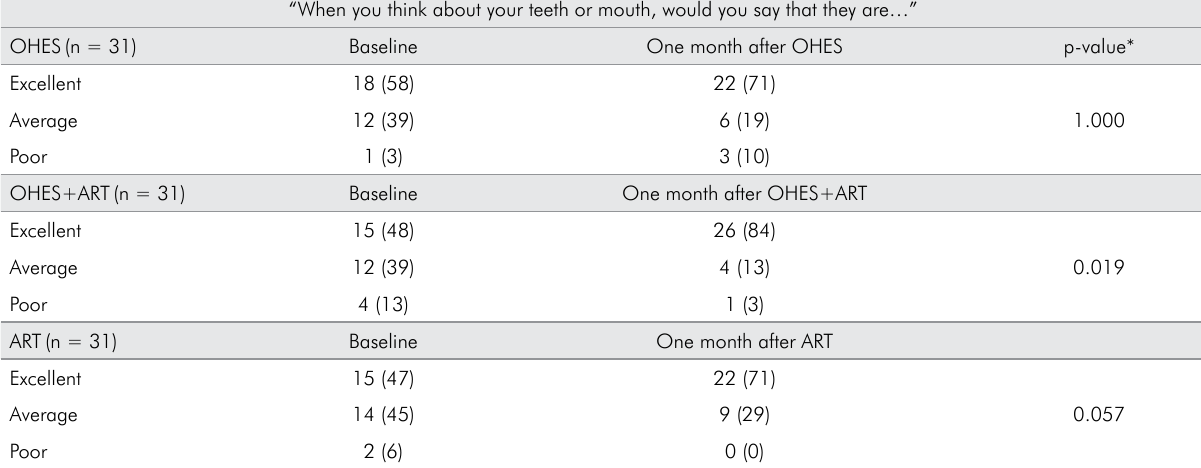
Table 3. Frequency [n (%)] of global oral health responses according to groups and follow-up